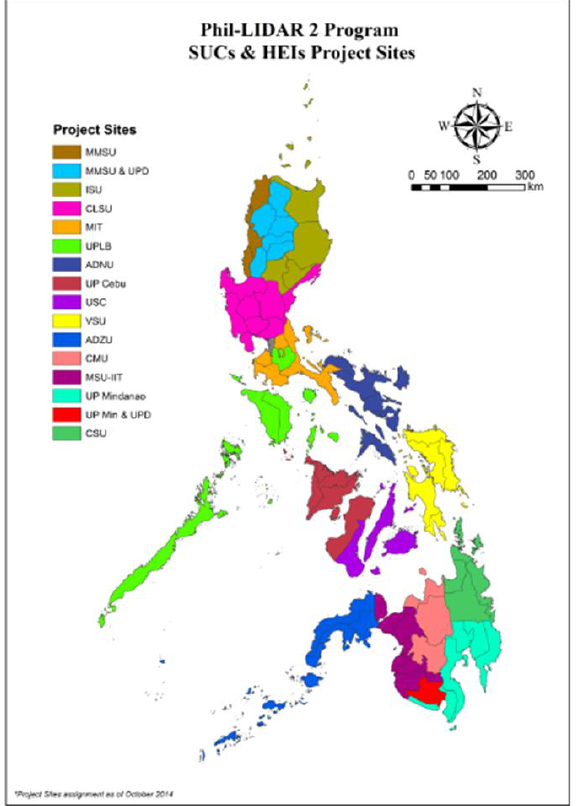
Figure 1. Project Sites of Phil-LiDAR 2 SUCs and